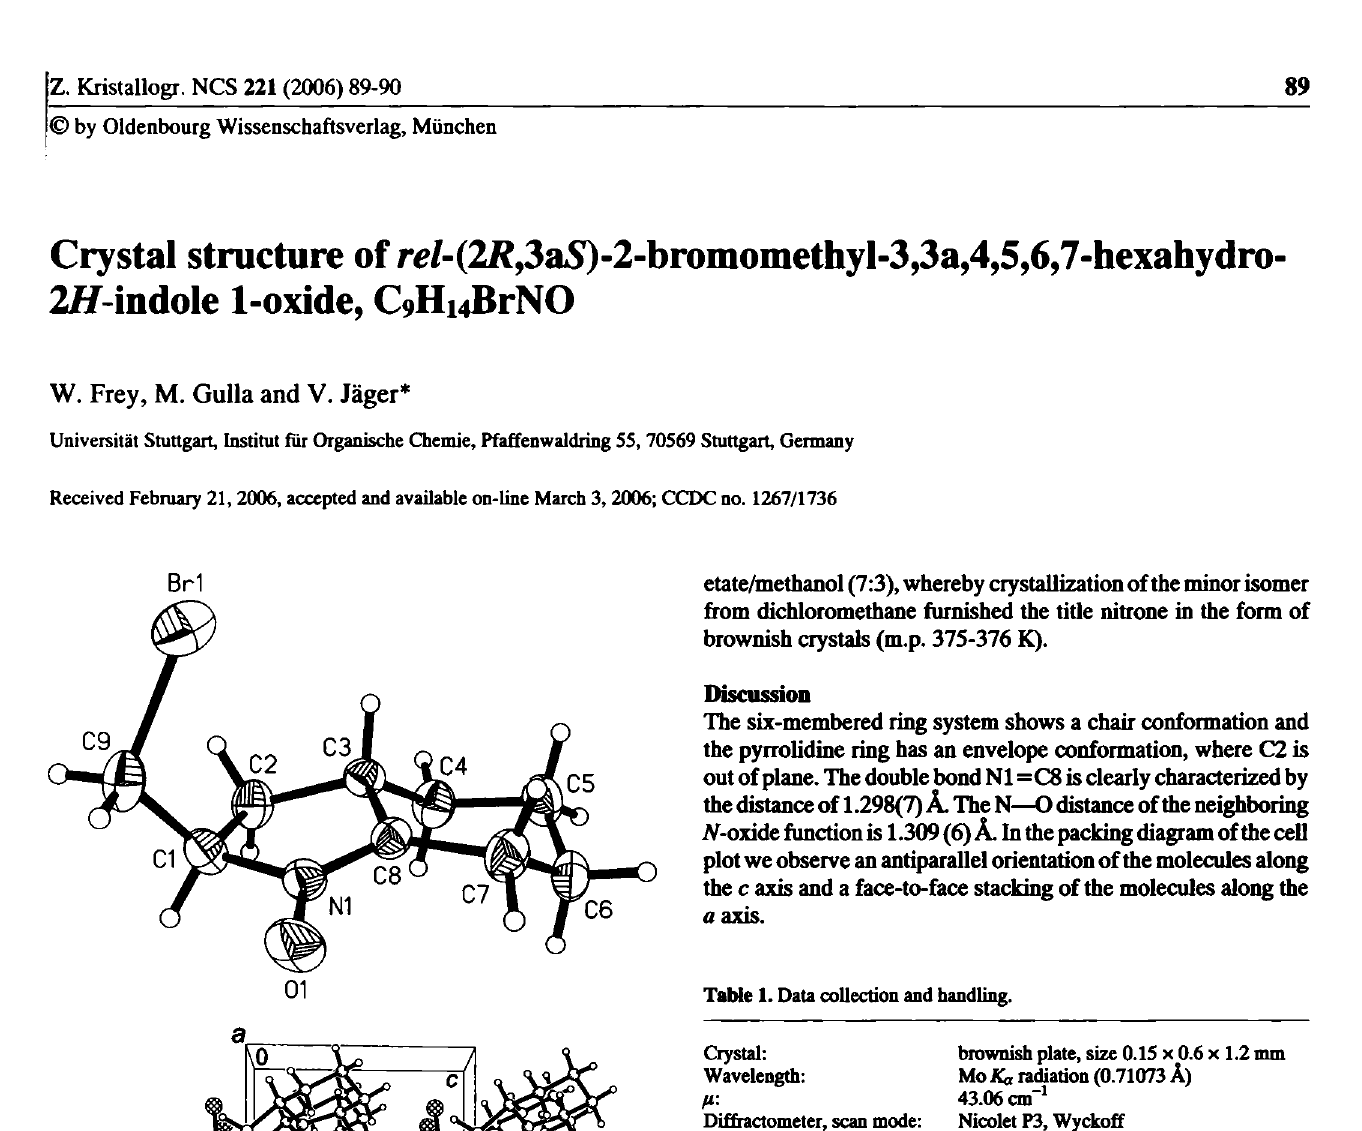
Table 2. Atomic coordinates and displacement parameters (in Ä 2